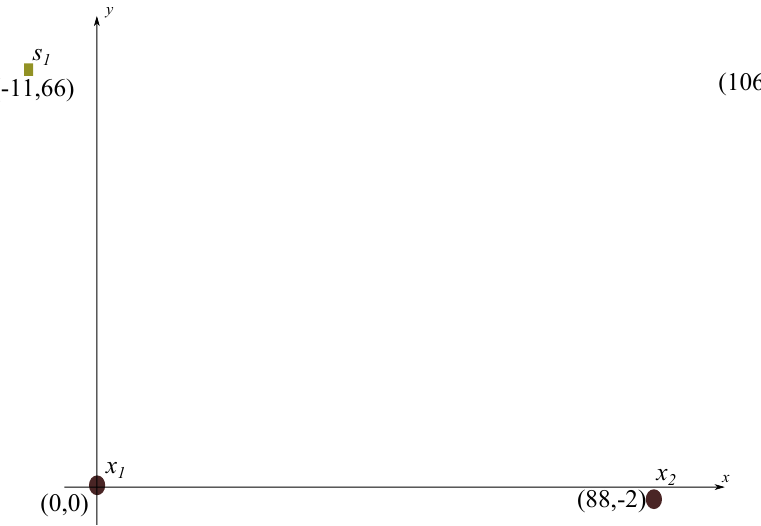
Figure 1. Picture of the experimental arrangement showing the two sources and the two antennas (UHF sensors) for partial discharge (PD) detection.